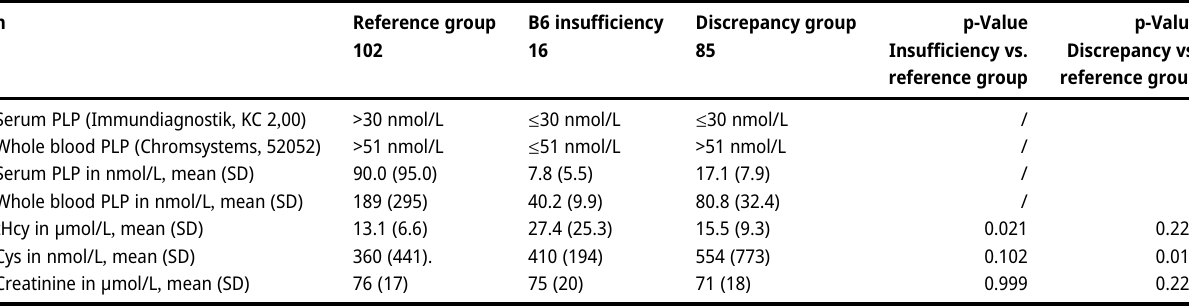
Table  : TheconcentrationsofserumandwholebloodPLP,metabolicPLPmarkersandcreatininein  samplesaccordingtosubgroupsofagreements between serum and whole blood PLP assays.